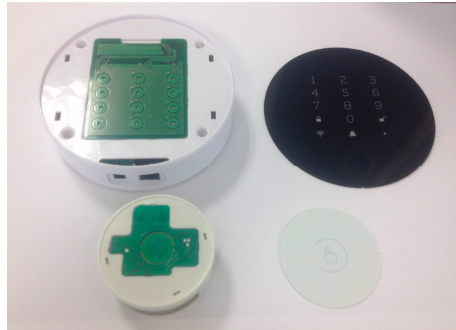
Figure 9. Image of the base station and gas sensor, and packing design.